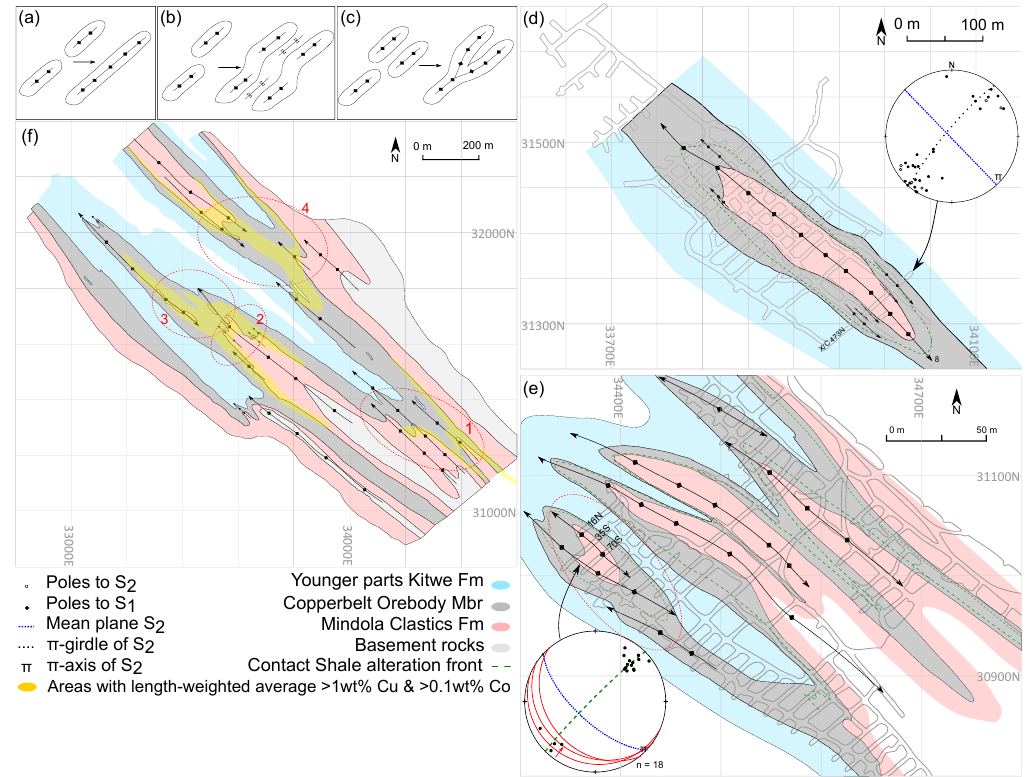
Figure 10. (a–c) Simplified illustration of concepts of fold linkage. (a) Direct fold linkage. (b) En echelon fold linkage. (c) Bifurcation fold linkage. (d–f) Geological plans of underground levels (approximately sub-horizontal) and equal-area lower-hemisphere stereoplots. (d) Geological map of section 7 at 3220 level around 473N crosscut in Nkana South. This section intersects a doubly plunging (periclinal) NW–SE-trending second-order fold geometry. Several third-order parasitic folds are present along the crosscuts. Stereoplot shows measure- ments in 473N crosscut, with the pole to S 1 cleavage plunging 8 ◦ towards the SE and axial planar S 2 cleavage. (e) Geological map of section 9 on 3140L at Nkana South. The stereoplot shows several shallow-dipping reverse faults trending NW–SE (e.g. Fig. 7d). Folds are tight-to-isoclinally folded and the COM is often pinched out (like in Fig. 9). The folds are arranged in a right-stepping en echelon system and are slightly periclinal. (f) Published geological plan by Brems et al. (2009) of 3360L in Nkana South, at around the same position of section 8, slightly towards the NE. Areas in yellow are orebodies as defined by Brems et al. (2009), containing > 1wt% Cu and 0.1wt% Co based on length-weighted composite assays from 186 horizontal drill holes. Interpretations of fold axial traces and patterns of geological layer boundaries show several interesting features, indicated by number 1 to 4. At (1), left-stepping en echelon folds develop. At (2) multiple parasitic folds develop in the Mindola Clastics Fm, where there are also (3) strongly non-cylindrical fold geometries. At (4), a non-cylindrical left-stepping en echelon structure develops, creating a